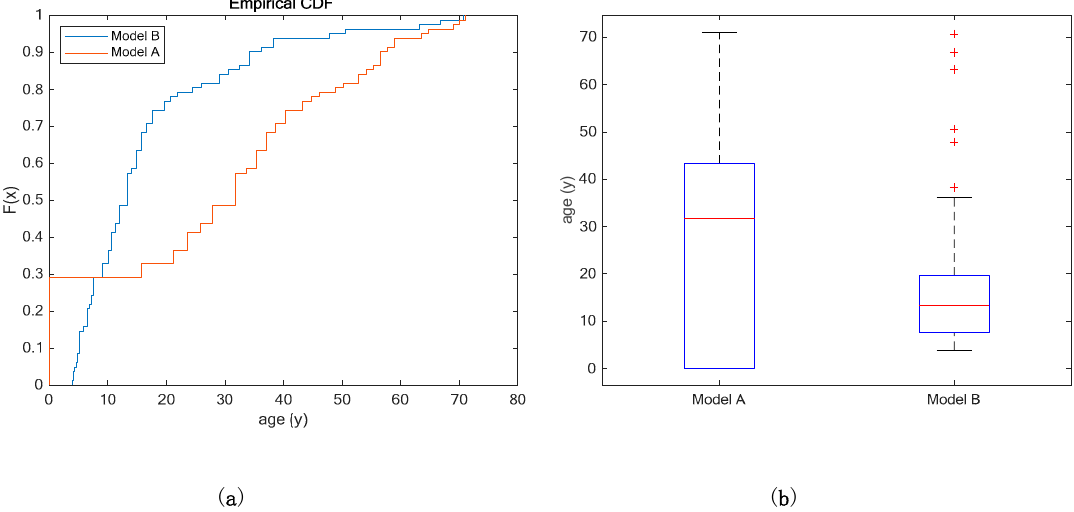
Figure 8. Age of the Eunicella verrucosa colonies off Sanremo estimated using model A and B. ( a ) Empirical distribution function; ( b ) Box plot showing median (red), first and third quartile (blue), range (whiskers), and outliers (red crosses). Here, outliers are values at a distance above the third quartile or below the first quartile greater than 1.5 times the interquartile range.